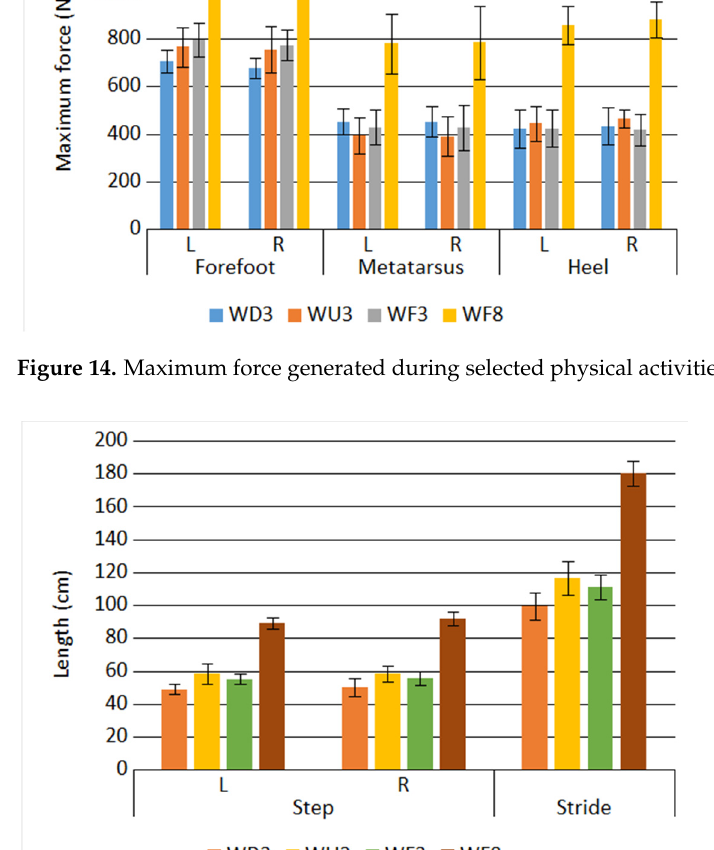
Figure 16. Generator output parameters for different physical activity types. The obtained results show that the highest RMS voltage was achieved for the WF8 activity and the lowest for the WF3 activity. It means that motion speed is the main factor influencing the generated voltage RMS value. Moreover, downhill and uphill motions are beneficial as compared to the motion on flat: the RMS voltages were higher when a tilt was nonzero. One can also observe that for the WF3 activity, the frequency of steps was higher than for WU3, although the RMS voltage value was lower. It may mean that max- imum force generated by a heel was important than the frequency of steps. The results show that both the physical activity type and the motion speed influence the efficiency of the EM generator used in the system. Basing on them, the WF8 activity was shown to be the most favorable from the point of view of energy.